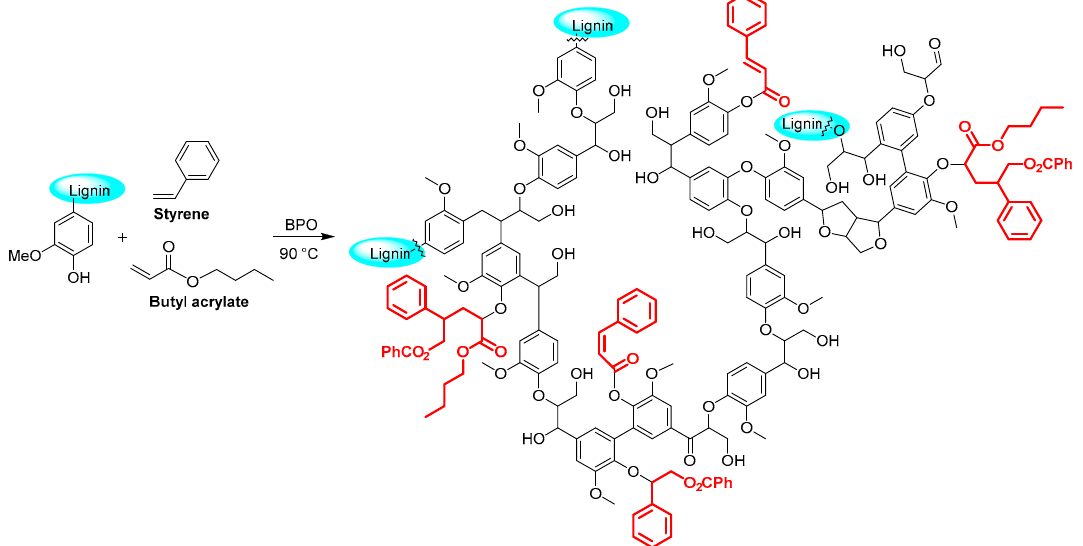
Scheme 2. Schematic diagram of the probable links in composites synthetized with lignin and styrene-